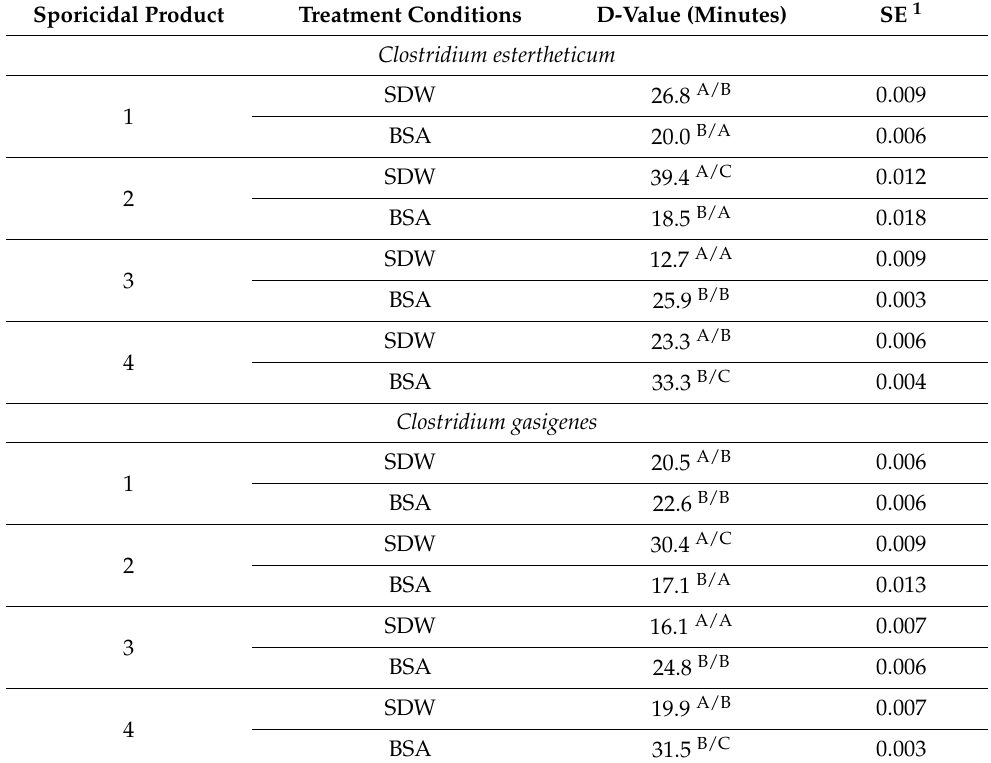
Table 2. The D-values for C. estertheticum and C. gasigenes treated with the different sporicidal products.